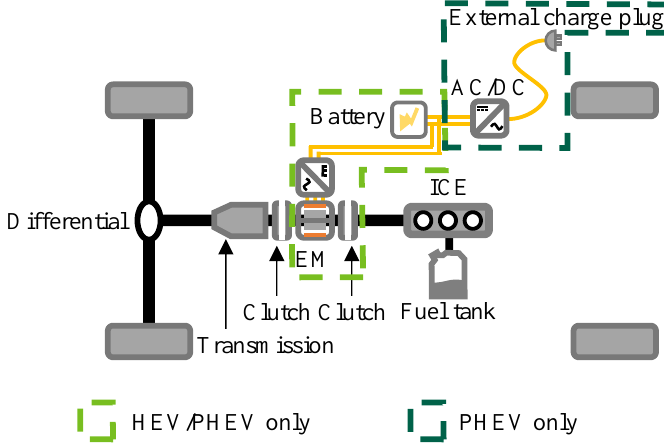
Figure 4. P2 parallel hybrid topology.